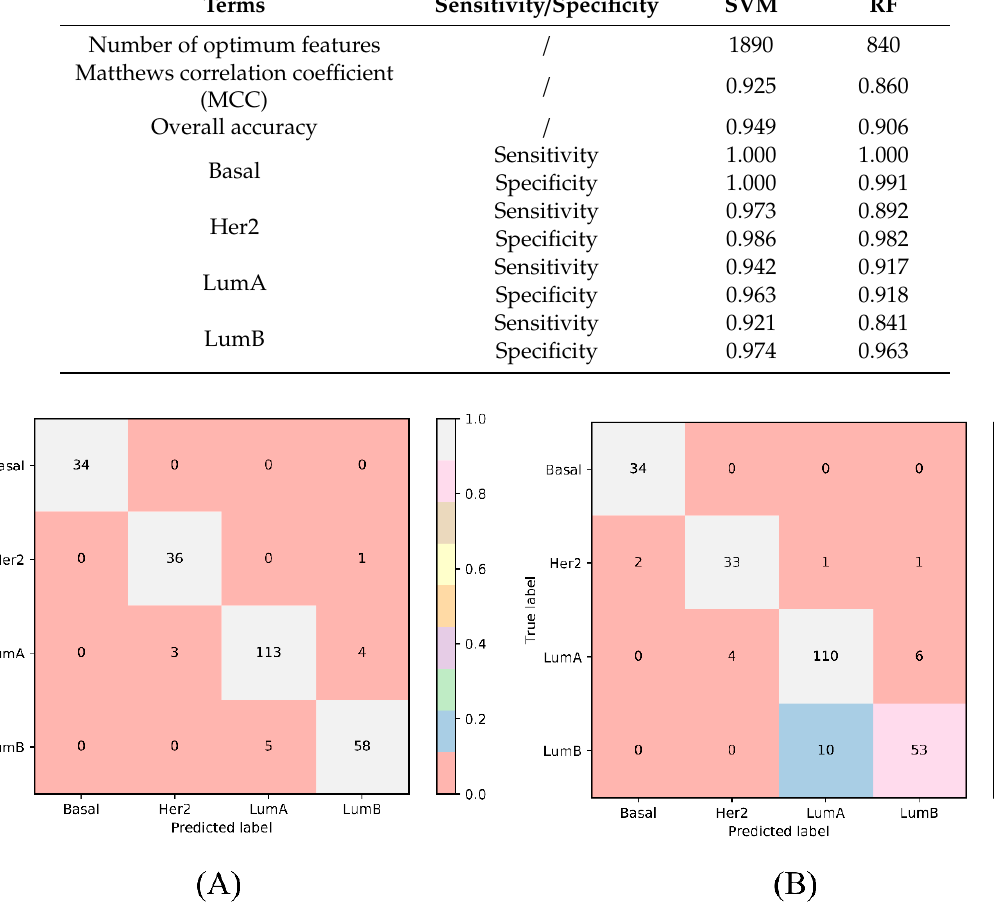
Figure 1. The confusion matrix yielded by the best support vector machine (SVM) and random forest (RF) classifiers. ( A ) The confusion matrix of the best SVM classifier; ( B ) The confusion matrix of the best RF classifier.